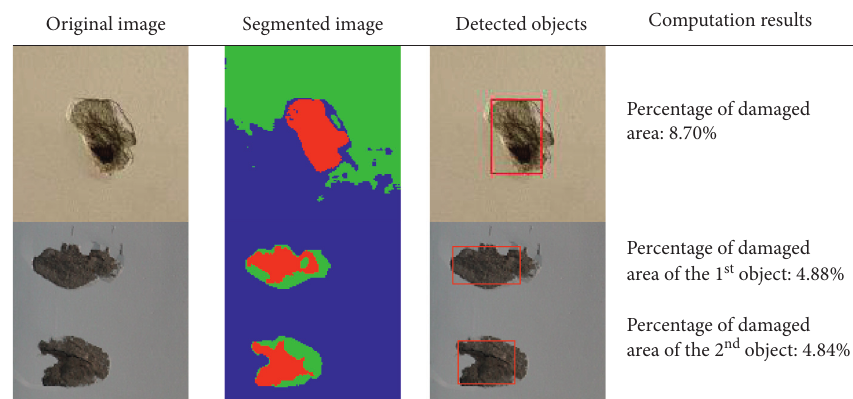
Figure 12: Demonstration of the calculation of the percentage of damaged areas.